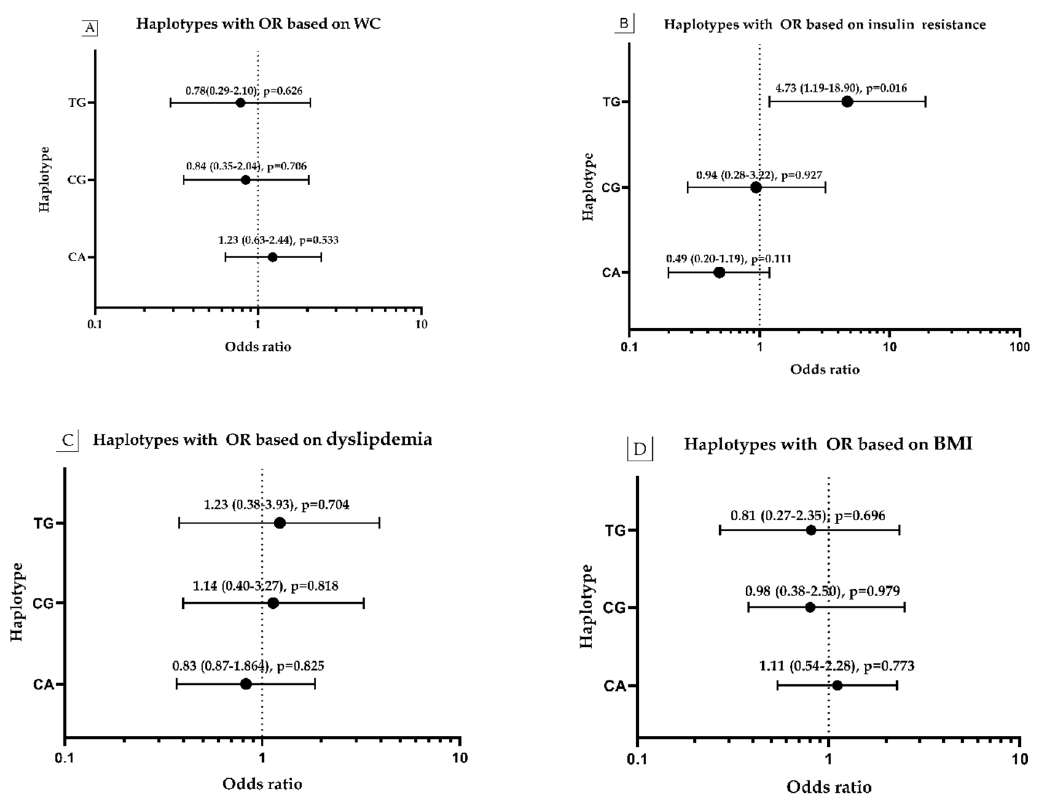
Figure 6. Haplotype association tests of co-segregated rs4986791 C > T, rs4986790 A > G with WC, IR, dyslipidemia, and BMI among obese subjects compared to non-obese subjects. Data are expressed as odds ratio (odds ratio of 95% lower and upper confidence interval (CI) with their p -values) for the independent variables: waist circumference ( A ); HOMA-insulin resistance ( B ); dyslipidemia ( C ); and BMI ( D ) with the haplotypes (CA, CG and TG) of the rs4986791 C > T and rs4986790 A > G among obese versus non-obese as controls. Logistic regression analysis was used for data analysis. Two-tailed p value is significant < 0.05.